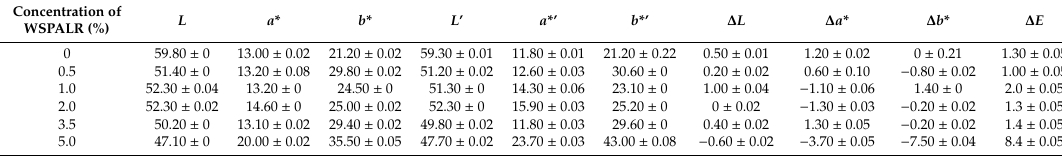
Table 3. E ff ect of WSPALR on the color di ff erence of waterborne coatings. Concentrationof WSPALR(%)